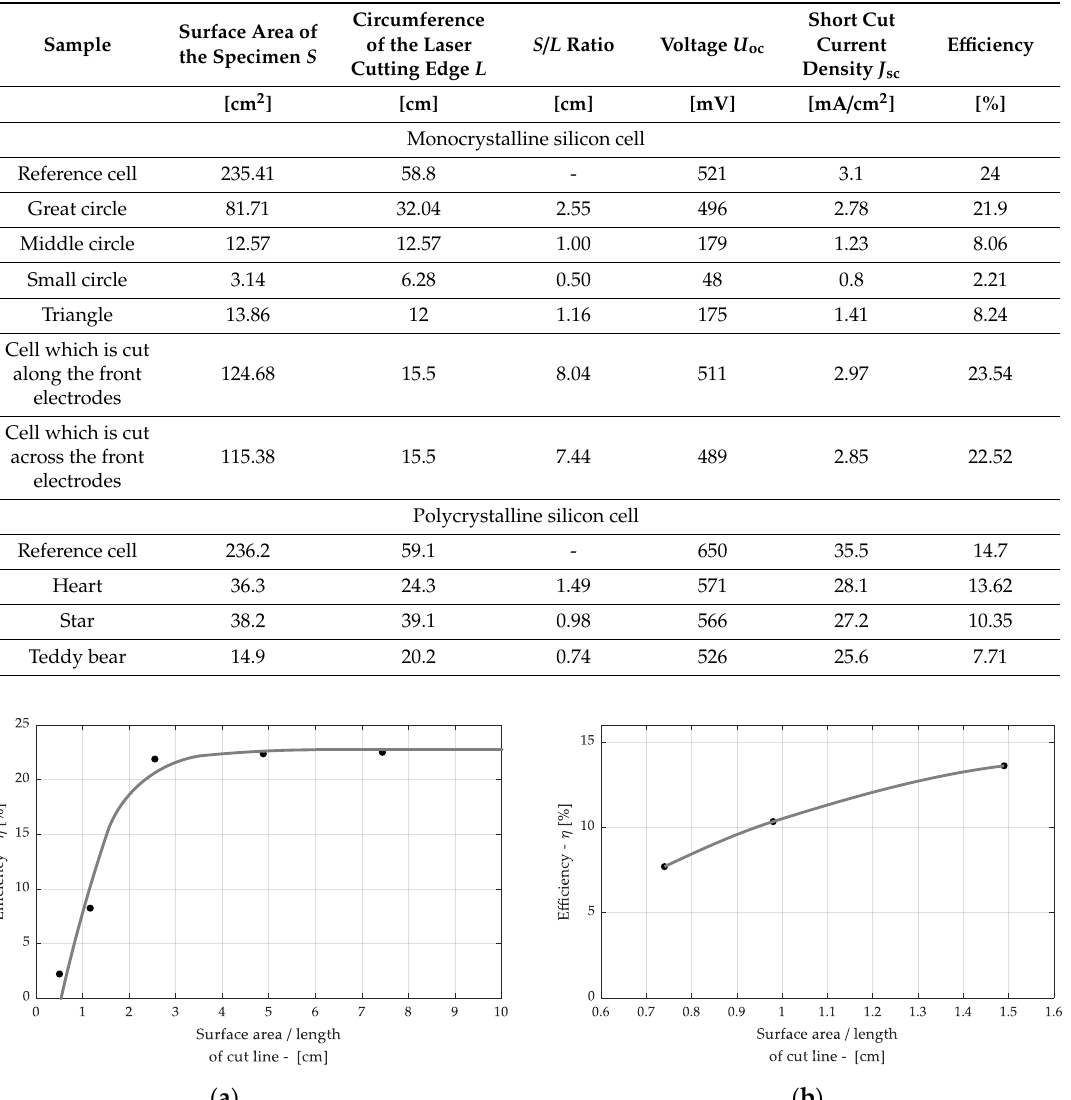
Table 4. Parameters of examined samples.